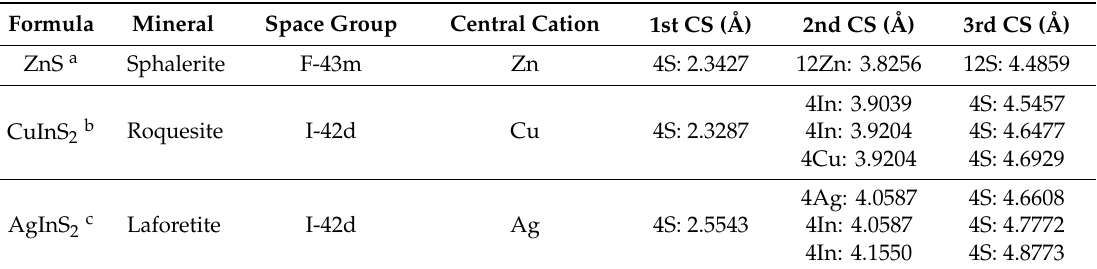
Figure 2. Top: First, second, and third coordination polyhedra around a cation in the structures of sphalerite ZnS ( a ) [22] and roquesite CuInS 2 ( b ) [23]. Bottom: Crystal structures of sphalerite (doubled cell is shown to make comparison with CuInS 2 easier) and roquesite [23]. Table 2. Interatomic distances in the three nearest-to-cation coordination shells (CS) in sphalerite ZnS, roquesite CuInS 2 , and laforetite AgInS 2 according to crystal chemical